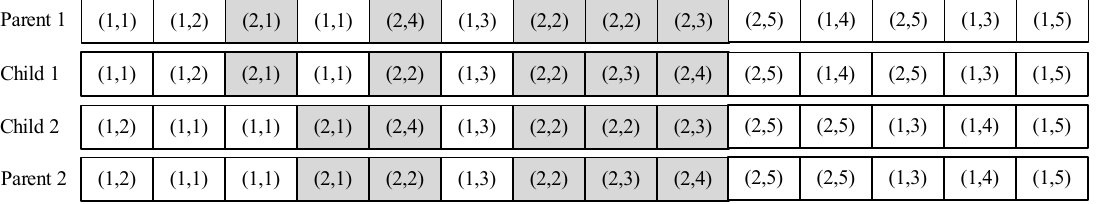
Figure 5. The crossover operation of the operation permutation.